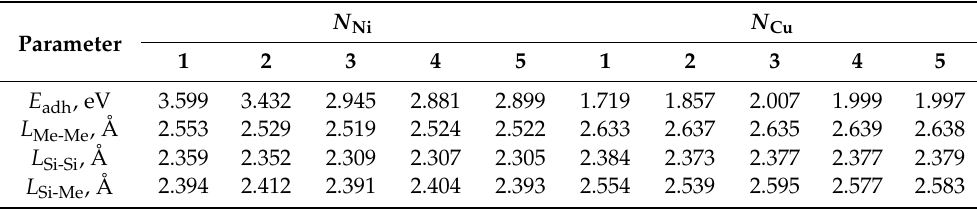
Table A1. Adhesion energy between silicene and N -layer (1–5) metal (Ni, Cu) substrates and bond lengths Me-Me, Si-Si, and Si-Me.